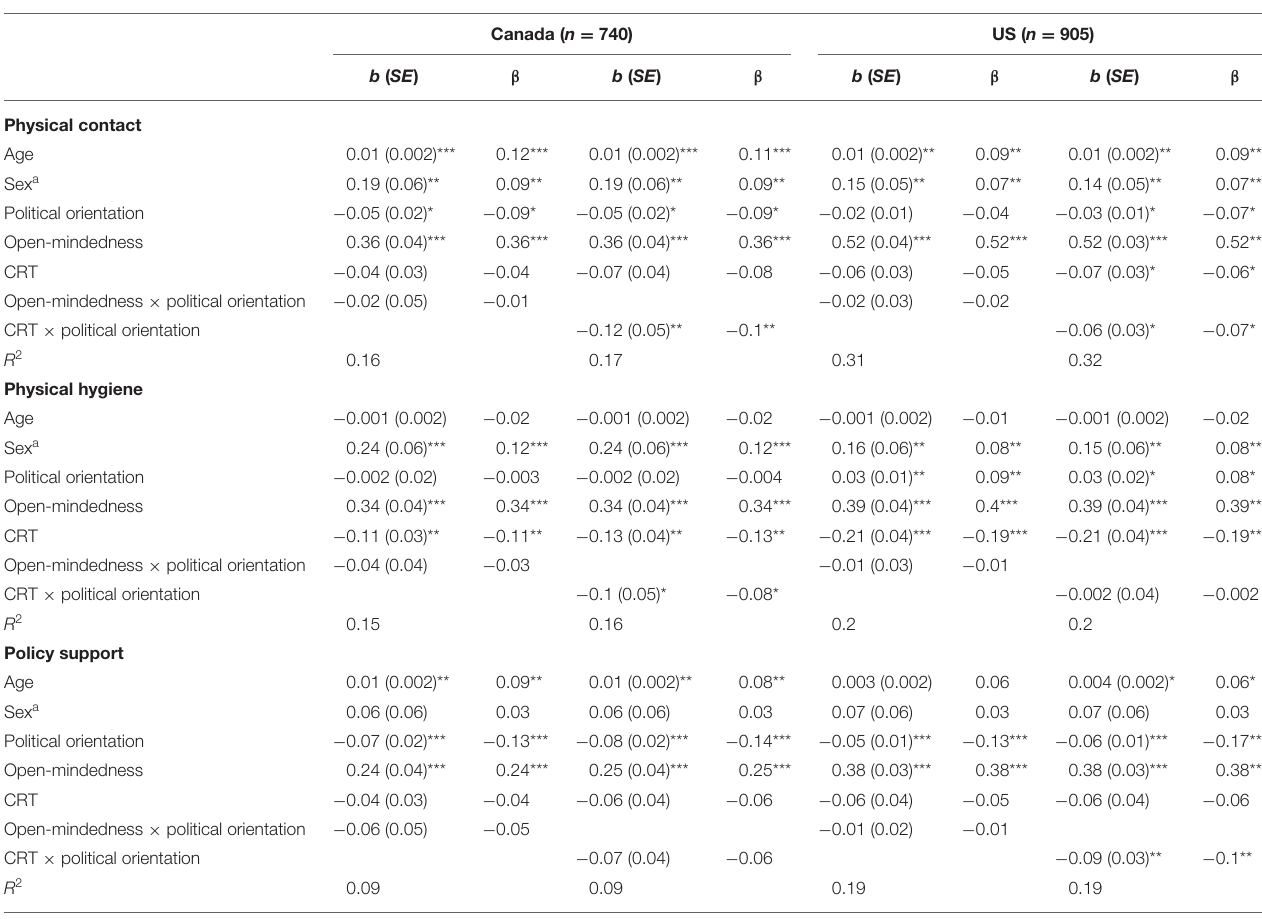
TABLE 6 | Multiple regression analyses interacting political orientation with open-mindedness and cognitive reflection in the prediction of our three dependent variables on separate samples from Canada ( n = 740) and the USA ( n = 905). Canada ( n =